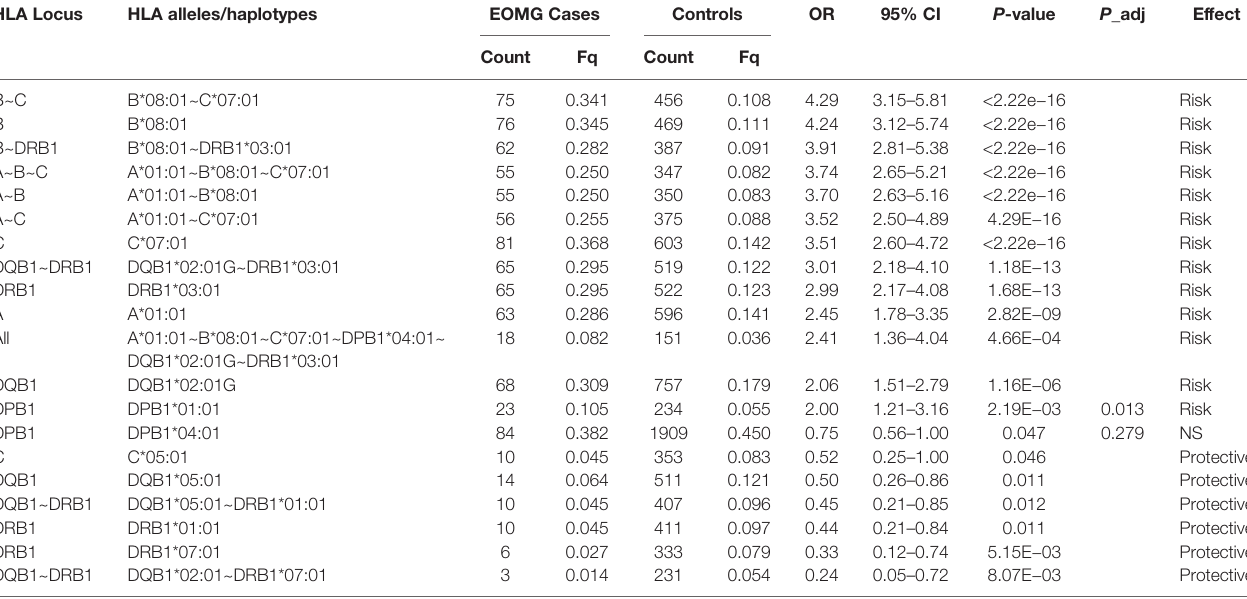
TABLE 4 | Signi fi cant associations of HLA alleles and haplotypes in Swedish EOMG AChR-antibody positive cases and controls ranked by odds ratios. HLA Locus HLA alleles/haplotypes